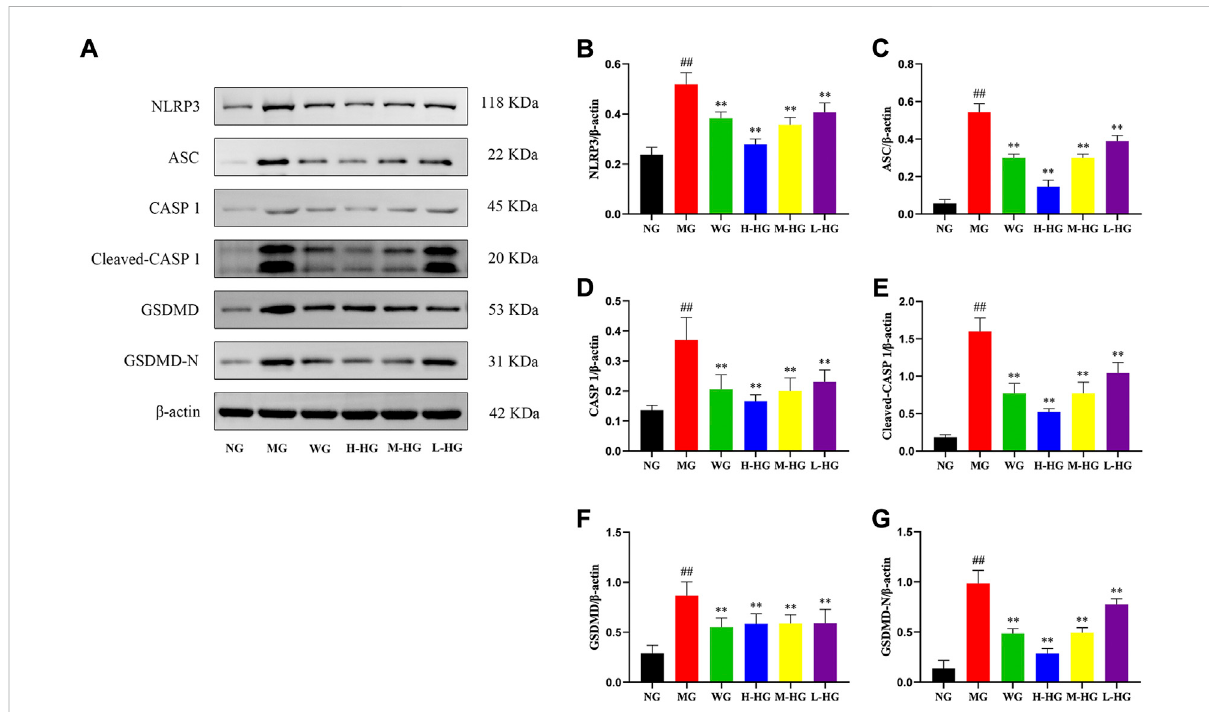
FIGURE 9 HZJDDrestrainedtheNLRP3/caspase-1pathwayofDSS-inducedUCinratsattheproteinlevel (A) .RelativeproteinlevelsofNLRP3 (B) ,ASC (C) , caspase-1 (D) , cleaved-caspase-1 (E) , GSDMD (F) and GSDMD-N (G) werenormalized to β -actin. Data are presented as themean ± SD (n = 3). ## p ＜ 0.01 vs NG, ** p < 0.01 or * p < 0.05 vs